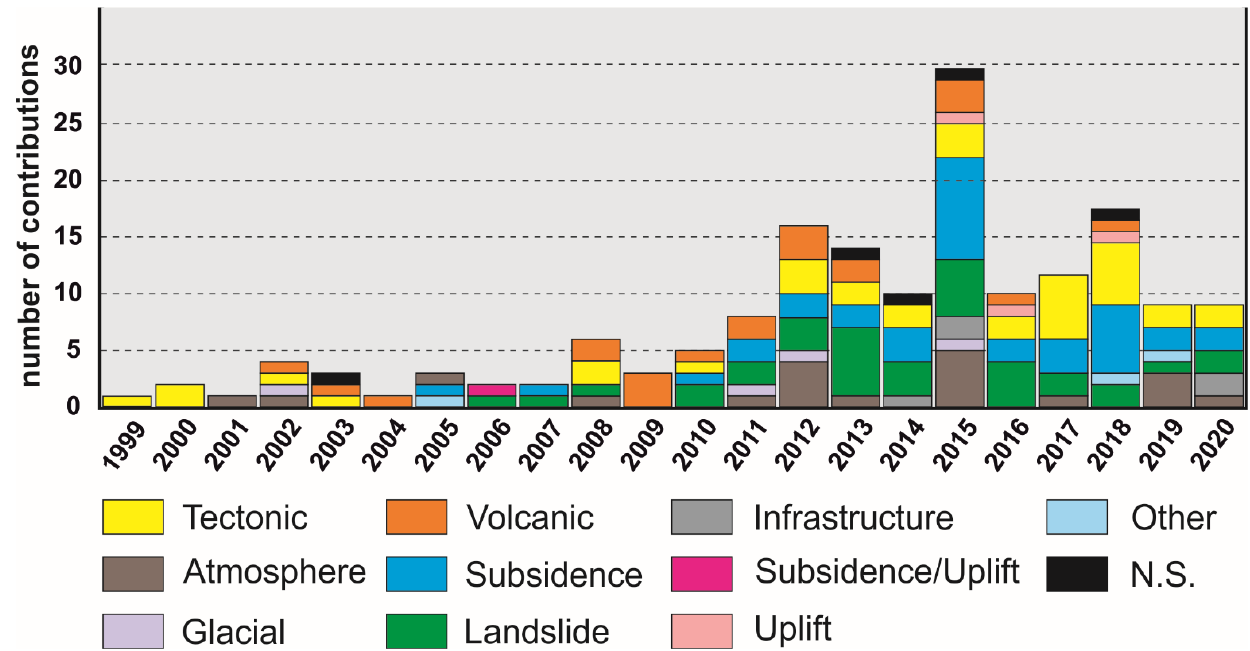
Figure 3. Temporal evolution of the scientific contributions combining GNSS and InSAR data in Europe considering the field of application.